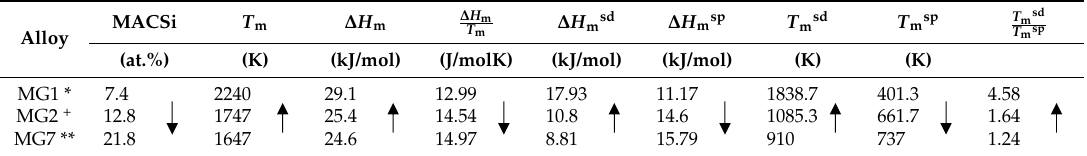
Table 1. Comparison of alloy parameters for the macrosegregation o Si in the cast alloys [27]. The arrows indicate “direction” of increase of specific parameter. The parameters were calculated as described in Reference [27].